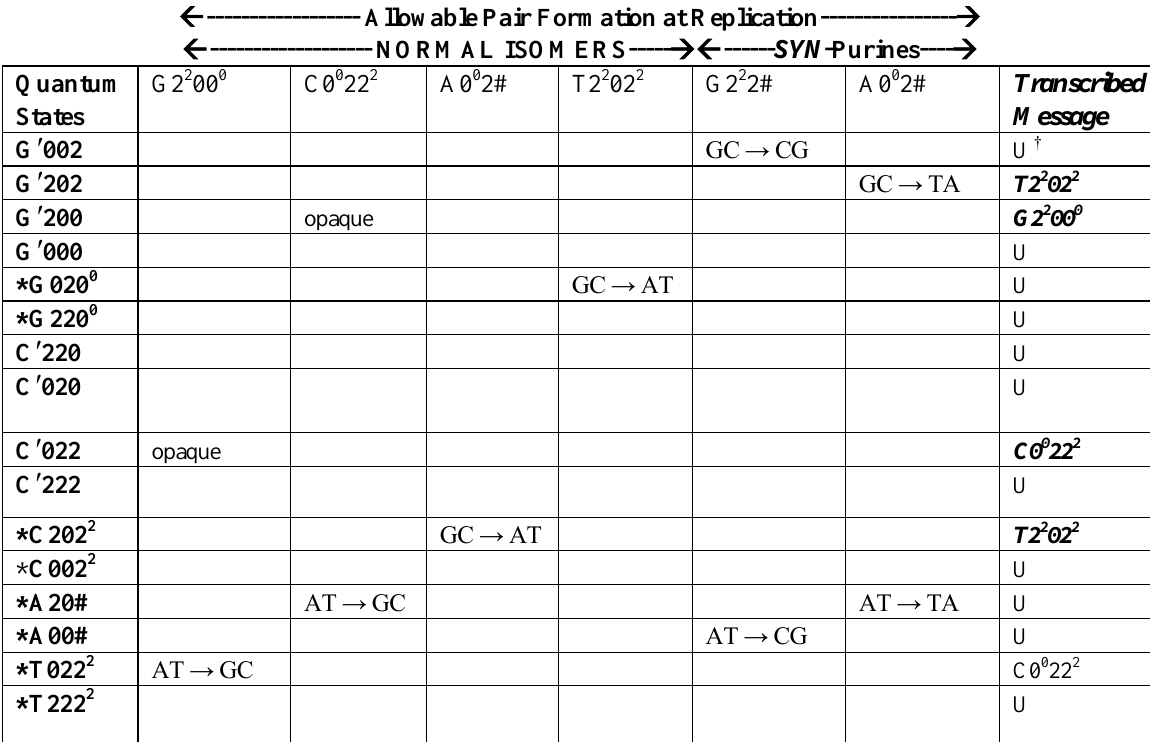
Table 1 . Relation between coherent states, transcribed message and base substitution of decohered